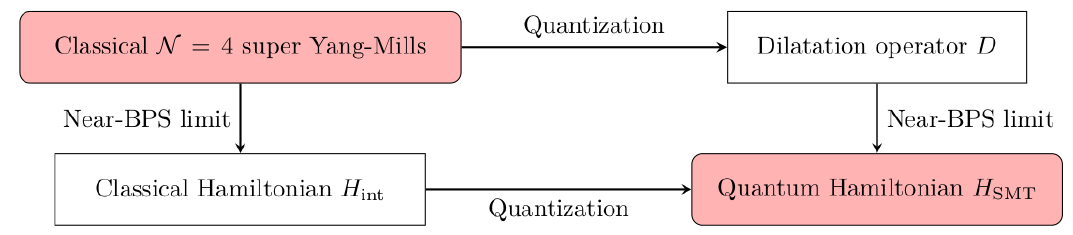
Figure 1 . Commutative diagram describing the relation between the methods 1 and 2 to go from the starting point, classical N = 4 SYM (top left), to the final result, an effective quantum SMT Hamiltonian (bottom down). According to method 1, we move right-down by computing one-loop corrections to the dilatation operator and then restricting to a near-BPS limit (1.2). Following method 2, we move down-right by performing the sphere expansion procedure and then giving a recipe to quantize the